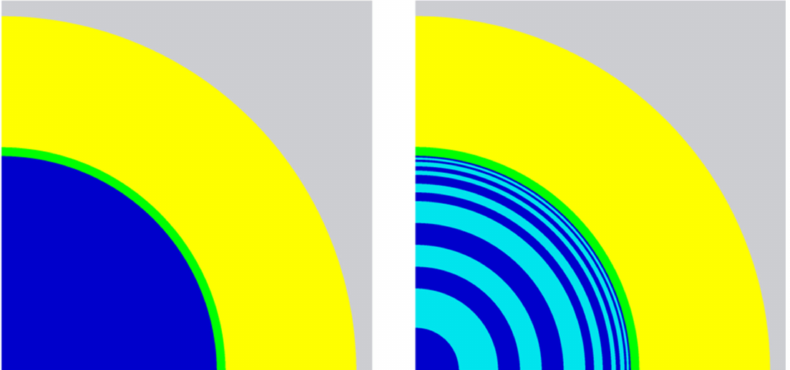
Figure 2. TRITON/NEWT model for the 2D study of reflector materials ( left ) and for the analysis of the variation of the effect of different reflector thicknesses (the thickness of the green reflector region is varied). The evaluation of the power distribution in the 2D system is based on a ring structure in the core ( right ). Molten salt core—blue; steel vessel—light green; reflector—yellow; surrounding